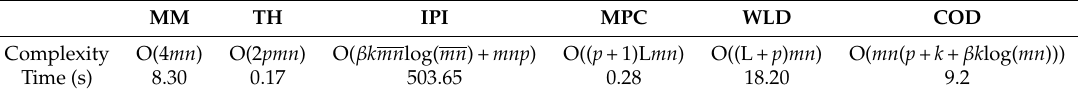
Table 6. Algorithm complexity and running time of the proposed method and other existing